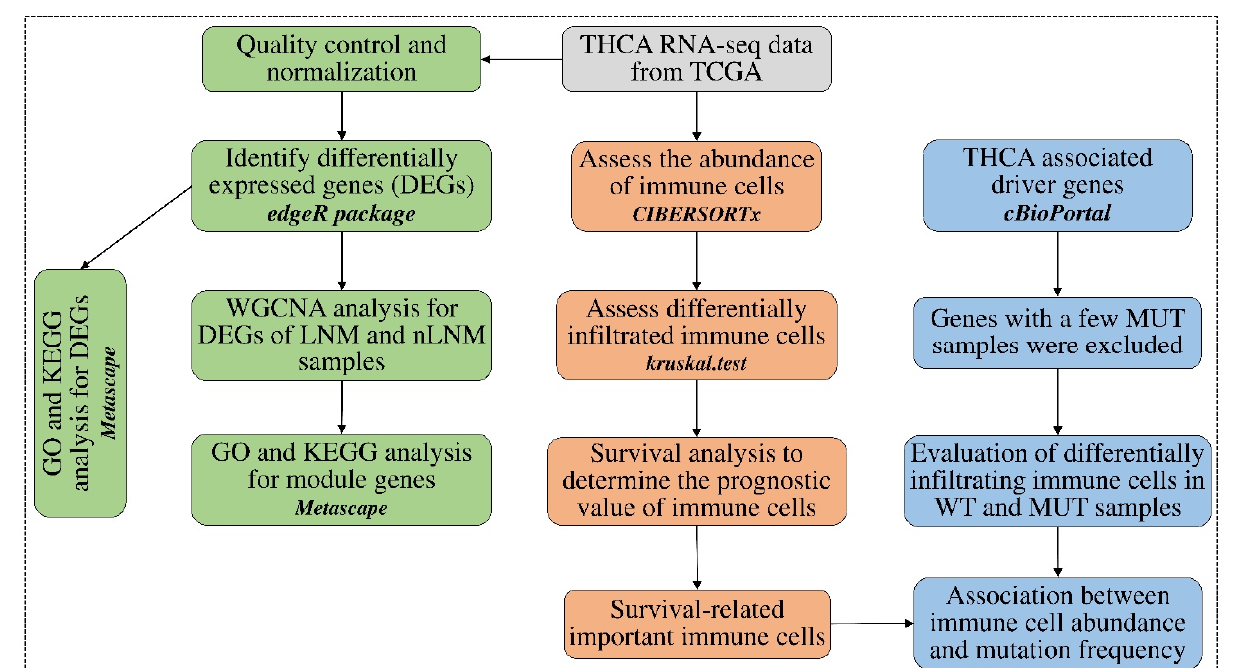
Figure 1. Flowchart of data analyses in the study. Three main analyses were conducted in the study: (i) The abundance of immune cells was estimated using CIBERSORTx. Differentially infiltrated immune cells between PTC groups were determined using the Kruskal–Wallis test. The association of immune cell abundances with patient survival was assessed using a univariate Cox regression model. (ii) Differentially expressed genes were identified between different PTC groups using edgeR. Immune cell-related biomarkers were identified using WGCNA analysis. (iii) The relation- ship between immune cell abundances and driver gene mutations in PTC was evaluated.